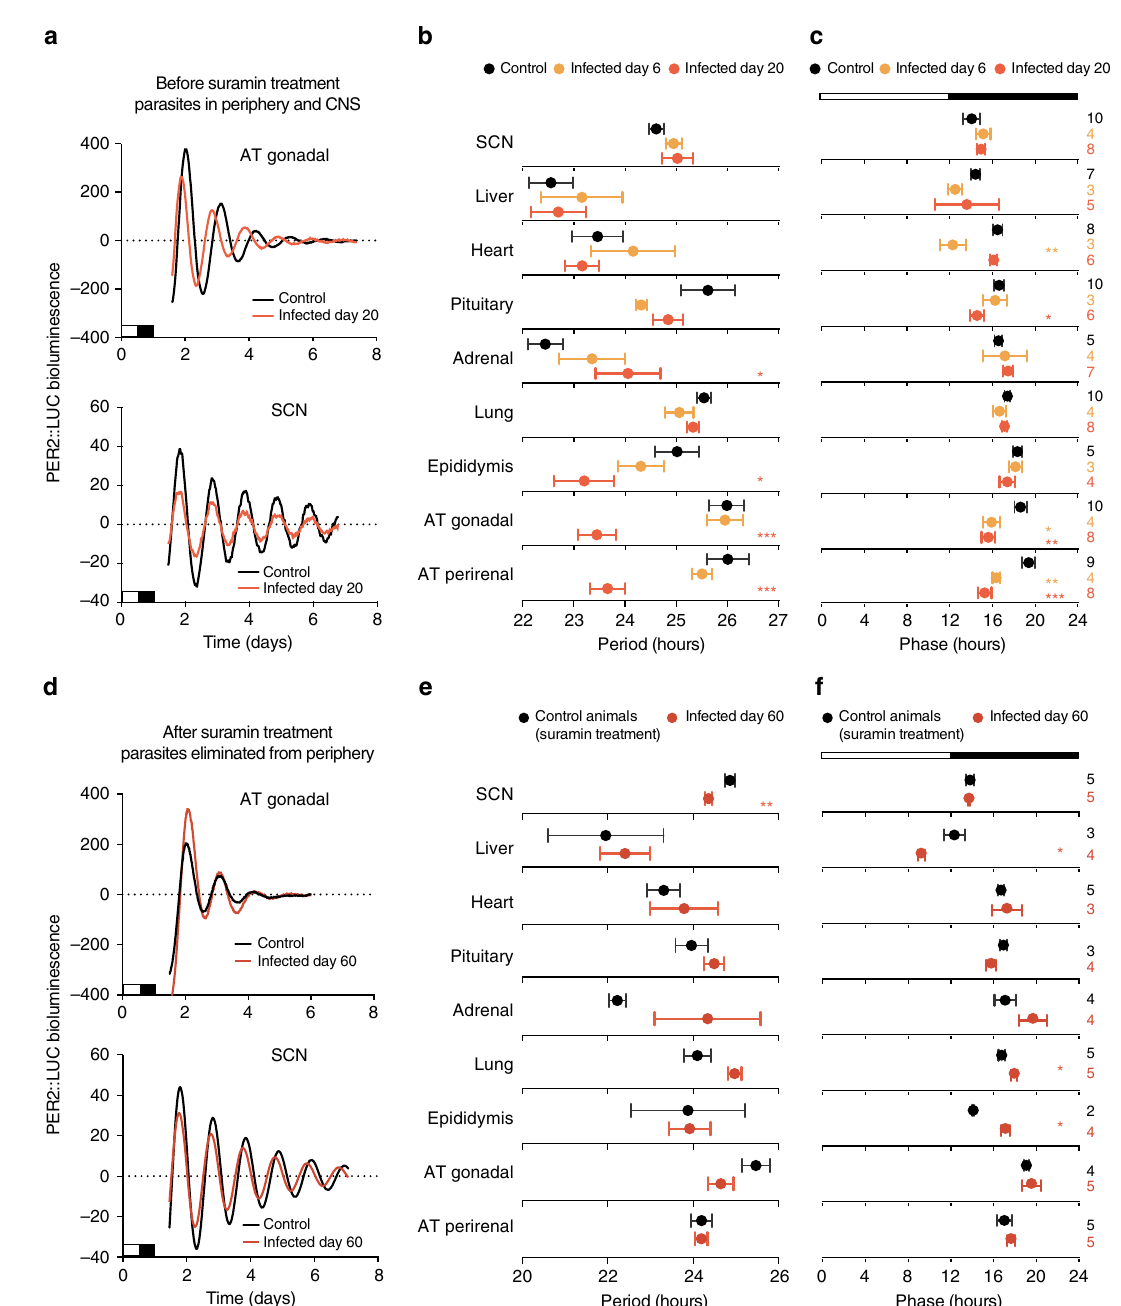
Fig. 3 Period of PER2::LUC explants becomes shorter when high number of parasites are present. a Representative normalized records of bioluminescence reporting PER2 circadian expression from gonadal adipose tissue and SCN on day 20 post-infection/vehicle. White and black box on the x -axis represent the light/dark cycle of mice before explants. b , c Period and phase plots of various tissues harvested from control (black) and infected mice (day 6 yellow, day 20 orange) mice. d Representative records of bioluminescence reporting of circadian expression from gonadal adipose tissue and SCN on day 60 post- infection/vehicle in animals treated with suramin (20 mg/kg). e , f Period and phase plots of various tissues harvested from control (black) and infected mice (day 60 dark orange) mice. Tissues were prepared from mice in LD. Shown are seven days of continuous recording after explant preparation. The sample size is indicated on the right. Shown are mean period ± s.d. for b , c and e , f panels; * adjusted p < 0.05, ** adjusted p < 0.01, *** p < 0.001,